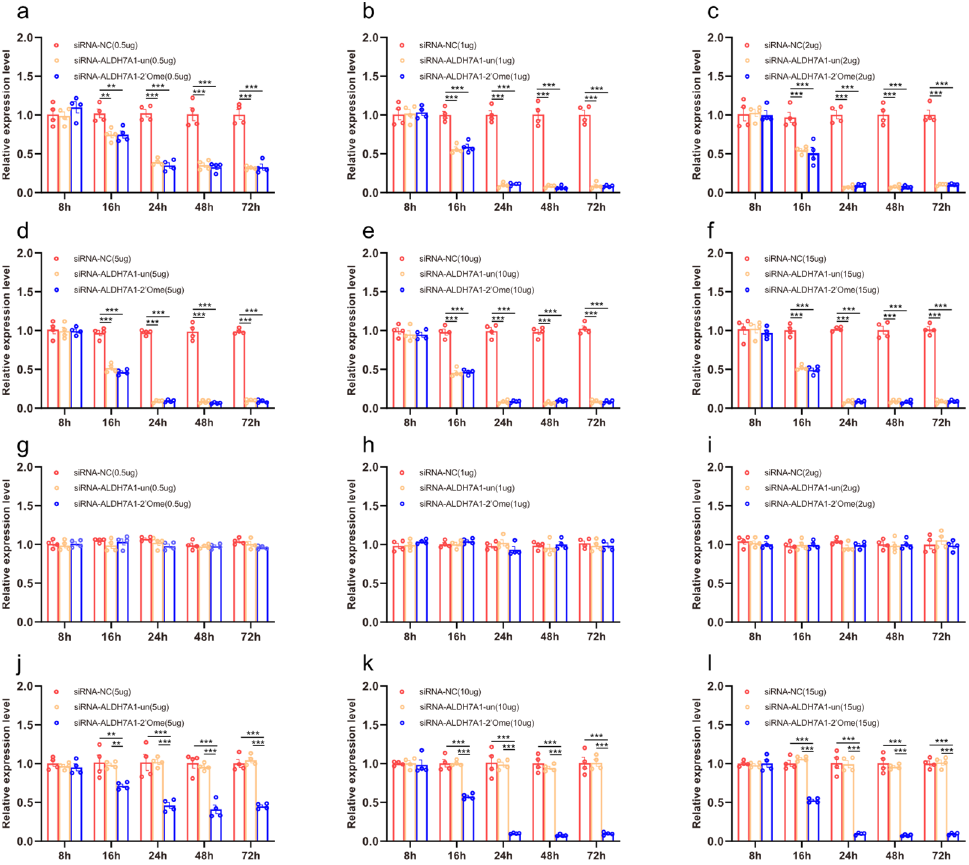
Figure 2. The effects of siRNA on ALDH7A1 mRNA transcripts in honey bee brains. The mRNA levels of ALDH7A1 were analyzed at 8 h, 16 h, 24 h, 48 h, and 72 h after injection of 0.5 μ g ( a ), 1 μ g ( b ), 2 μ g ( c ), 5 μ g ( d ), 10 μ g ( e ), and 15 μ g ( f ) siRNA, or after feeding of 0.5 μ g ( g ), 1 μ g ( h ), 2 μ g ( i ), 5 μ g ( j ), 10 μ g ( k ), and 15 μ g ( l ) siRNA. The red column shows the relative expression of siRNA-NC injected. The orange column shows the relative expression of siRNA-ALDH7A1-un injected. The blue column shows the relative expression of siRNA-ALDH7A1-2 ′ Ome injected. Each circle represents a biological repeat. ** indicates p < 0.01; *** indicates p < 0.001, tested by ANOVA test. Detailed data are shown in Table S2.